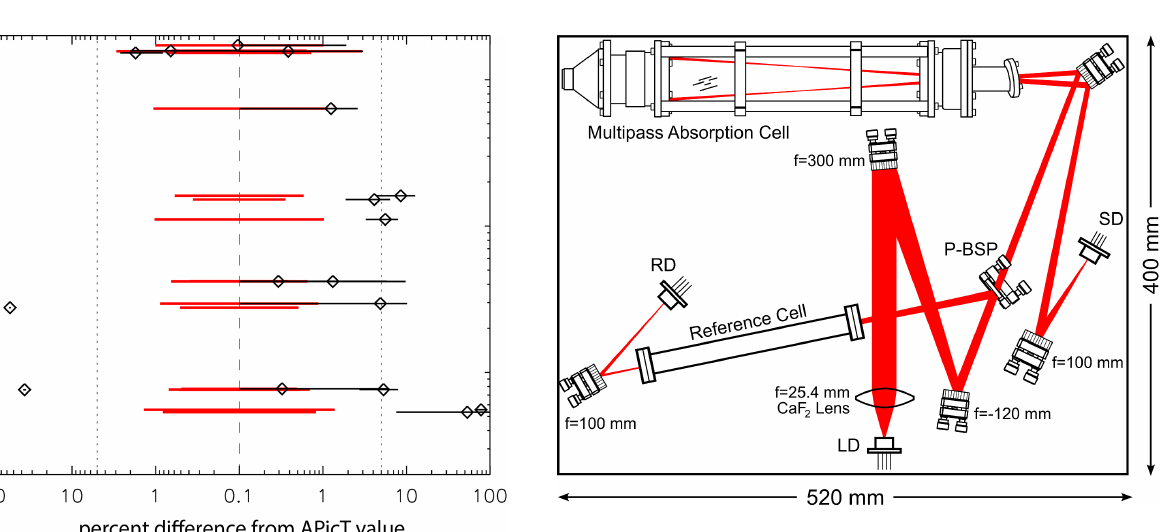
Figure A10. ISOWAT schematic. The beam of a tunable diode laser (LD) is focused into a multipass-absorption cell to achieve 76m ab- sorption pathlength. The sample detector (SD) records the multipass cell signal. A high-concentration reference cell in combination with the reference detector (RD) is used for laser wavelength stabiliza-